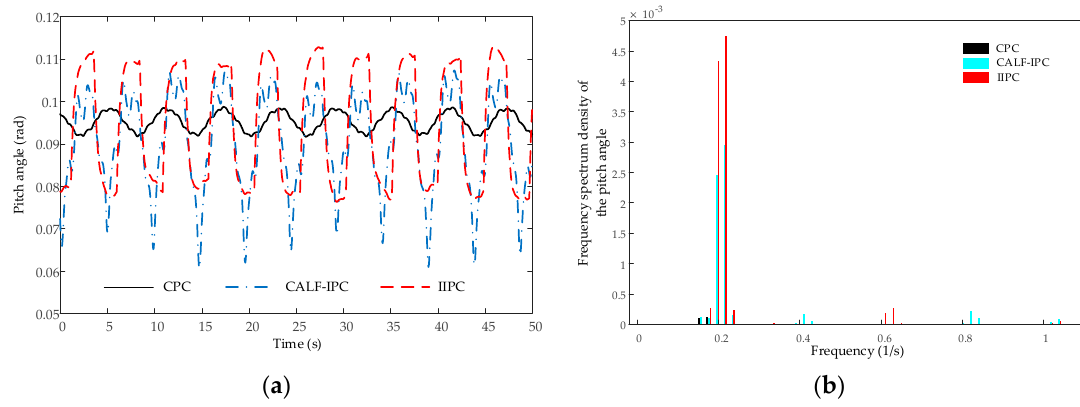
Figure 14. Time domain and frequency domain results of pitch angle under different control: ( a ) Curves of the pitch angle; ( b ) Frequency spectrum density of the pitch angle.